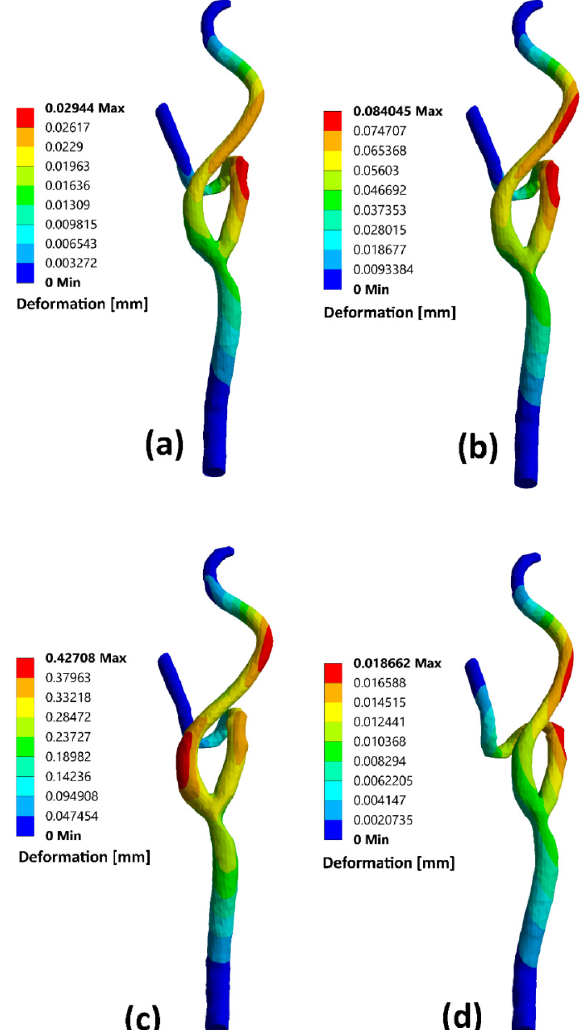
Figure 12. CA—model C deformation contours for different times of the cardiac cycle: ( a ) t = 0.02 s, ( b ) t = 0.16 s, ( c ) t = 0.385 s, and ( d ) t = 0.74 s.